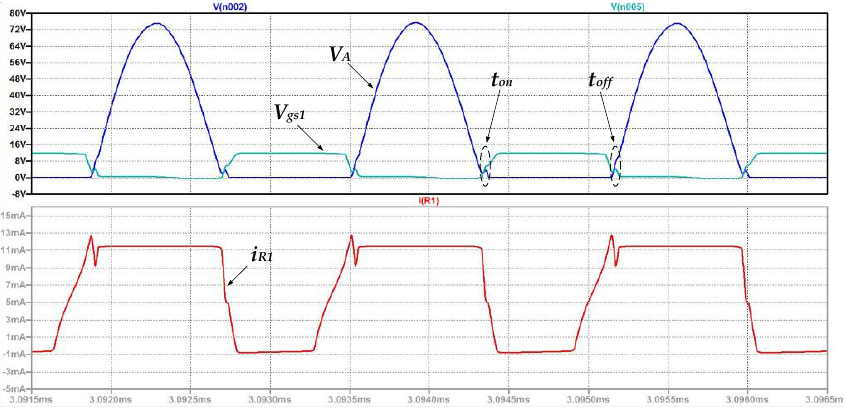
Figure 9. Voltage and current waveforms of the improved circuit simulation at V DC = 24 V and V drive = 12 V.